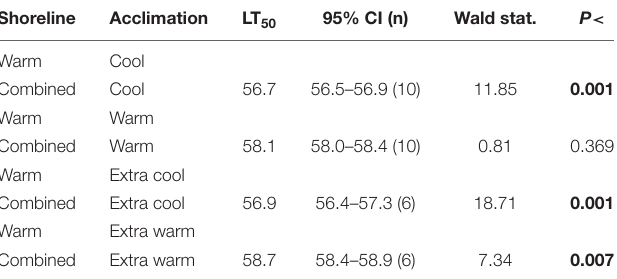
TABLE 3 | Statistical information comparing effects of warm-shore (WS) and combined-shore (warm and cool) on the LT 50 of Echinolittorina malaccana for the various acclimation